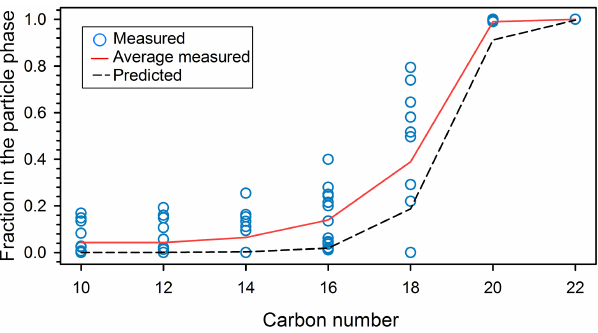
Figure 1. Fraction of PAHs in the particle phase as a function of the number of carbon atoms. Circles represent the daily measured F p ( n = 14), the red line represents average F p , and the dotted line (black) is the predicted F p using the absorption model (Ta- ble S1). Select PAHs were used compare ambient measurements and model estimation: C 10 is naphthalene, C 12 is acenaphthene, C 14 is anthracene, C 16 is pyrene, C 18 is benzo(ghi)fluoranthene, C 20 is benzo(b)fluoranthene, and C 22 is